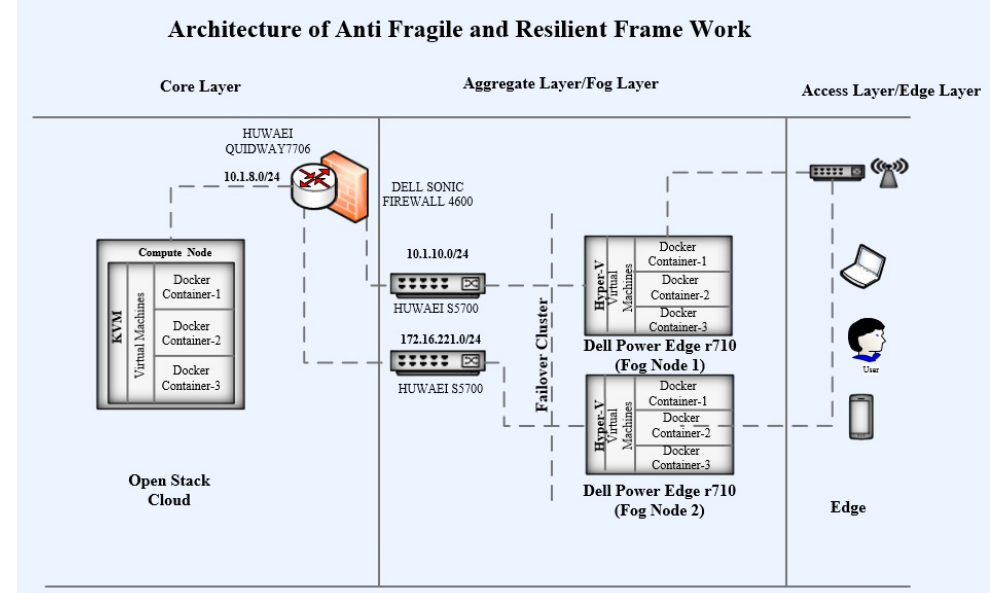
Figure 6. Architecture of the anti-fragile and resilient